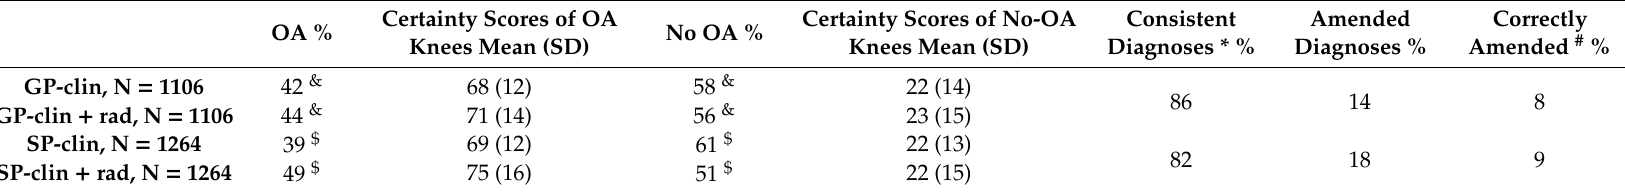
Table 2. Expert diagnoses and certainty scores.